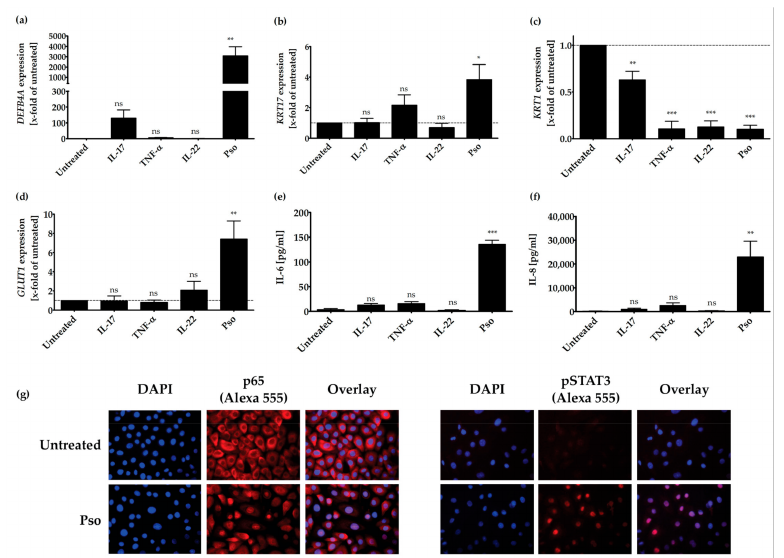
Figure 1. IL-17A-, TNF- α - and IL-22-induced synergy by expression of psoriasis-related genes or proteins. HPK were stimulated with IL-17A (20 ng/mL), TNF- α (20 ng/mL), IL-22 (20 ng/mL) or a combination of these cytokines (Pso) for 24 h. ( a ) DEFB4A , ( b ) KRT17 , ( c ) KRT1 and ( d ) GLUT1 mRNA expression was analyzed by real time qRT-PCR ( n = 3). ACTB was used as reference gene for normalization. Protein level of secreted IL-6 ( e ) and IL-8 ( f ) was measured in the cell culture supernatant by ELISA ( n = 3). The dotted line indicates the value of the untreated sample. Data shown as mean ± SD of three independent experiments. ( g ) HPK were stimulated with the cytokine combination (20 ng/mL of IL-17A, IL-22 and TNF- α , Pso) for 24 h and immunofluorescence stainings of p65 NF κ B and pSTAT3 were performed. The nucleus is stained with DAPI. Representative pictures of p65 NF κ B and pSTAT3 staining in untreated and cytokine-treated cells. The % of total protein in the nucleus was measured using the Intensity Ratio Nuclei Cytoplasm Tool (RRID:SCR_018573) in ImageJ. Data shown as mean ± SD of five independent experiments with two pictures per experiment. Statistics were always one-way ANOVA with Newman-Keuls post-test. * p ≤ 0.05, ** p ≤ 0.01, *** p ≤ 0.001, ns-not significant ( p >